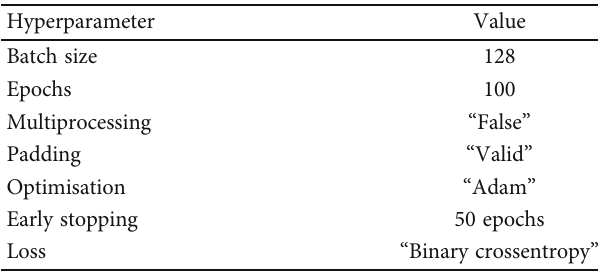
Table 4: Hyperparameters and their values.